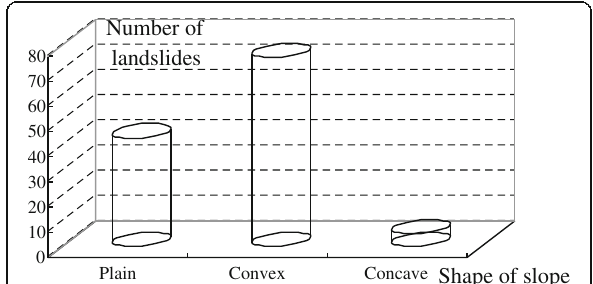
Fig. 18 Relationships between the shape of slope and landslide occurrence